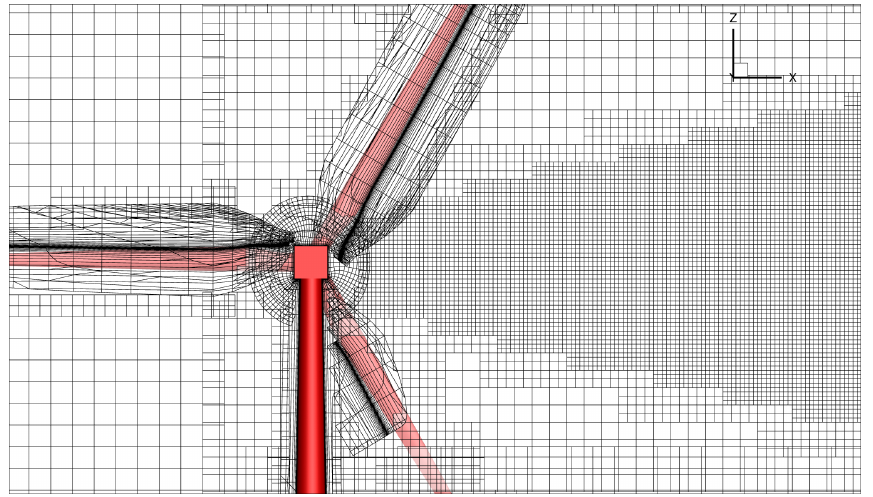
Figure 9. CFD grids around the WT, with the WT surface in red; for more clarity, every 4th grid line is plotted